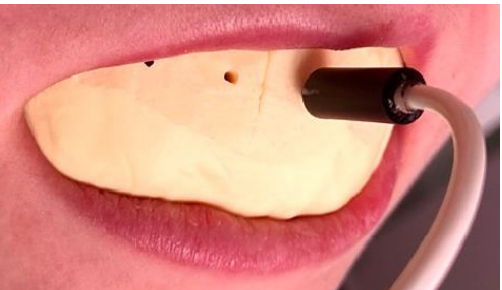
Figure 3. The LDF probe holder maintained the Doppler laser probe oriented towards the cervical third of the vestibular surface of the teeth selected in the study.